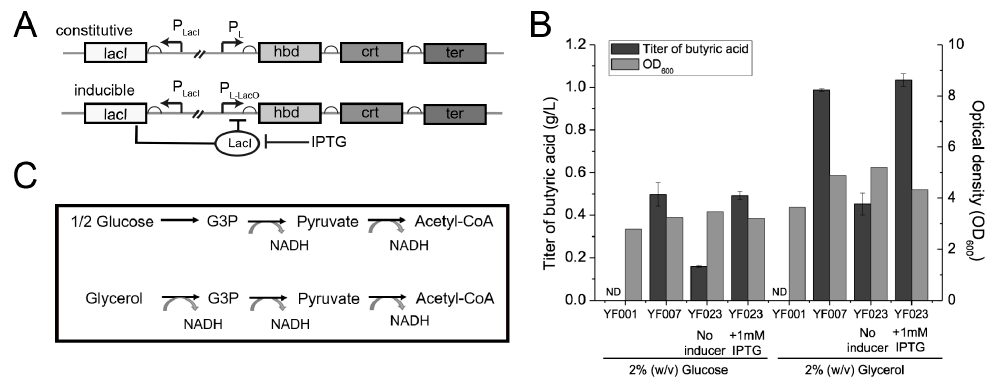
Figure 2. Optimization of conditions for C4 production. ( A ) Constitutive and inducible expression systems for C4 production. (LacI, lac repressor; LacO, lac operator.) ( B ) C4 titers and cell mass (optical density at 600 nm [OD 600 ]) of the engineered strains YF007 and YF023 under different conditions. (ND, not detected). ( C ) Comparison of catabolism of glycerol and glucose for supply of NADH reducing equivalent.